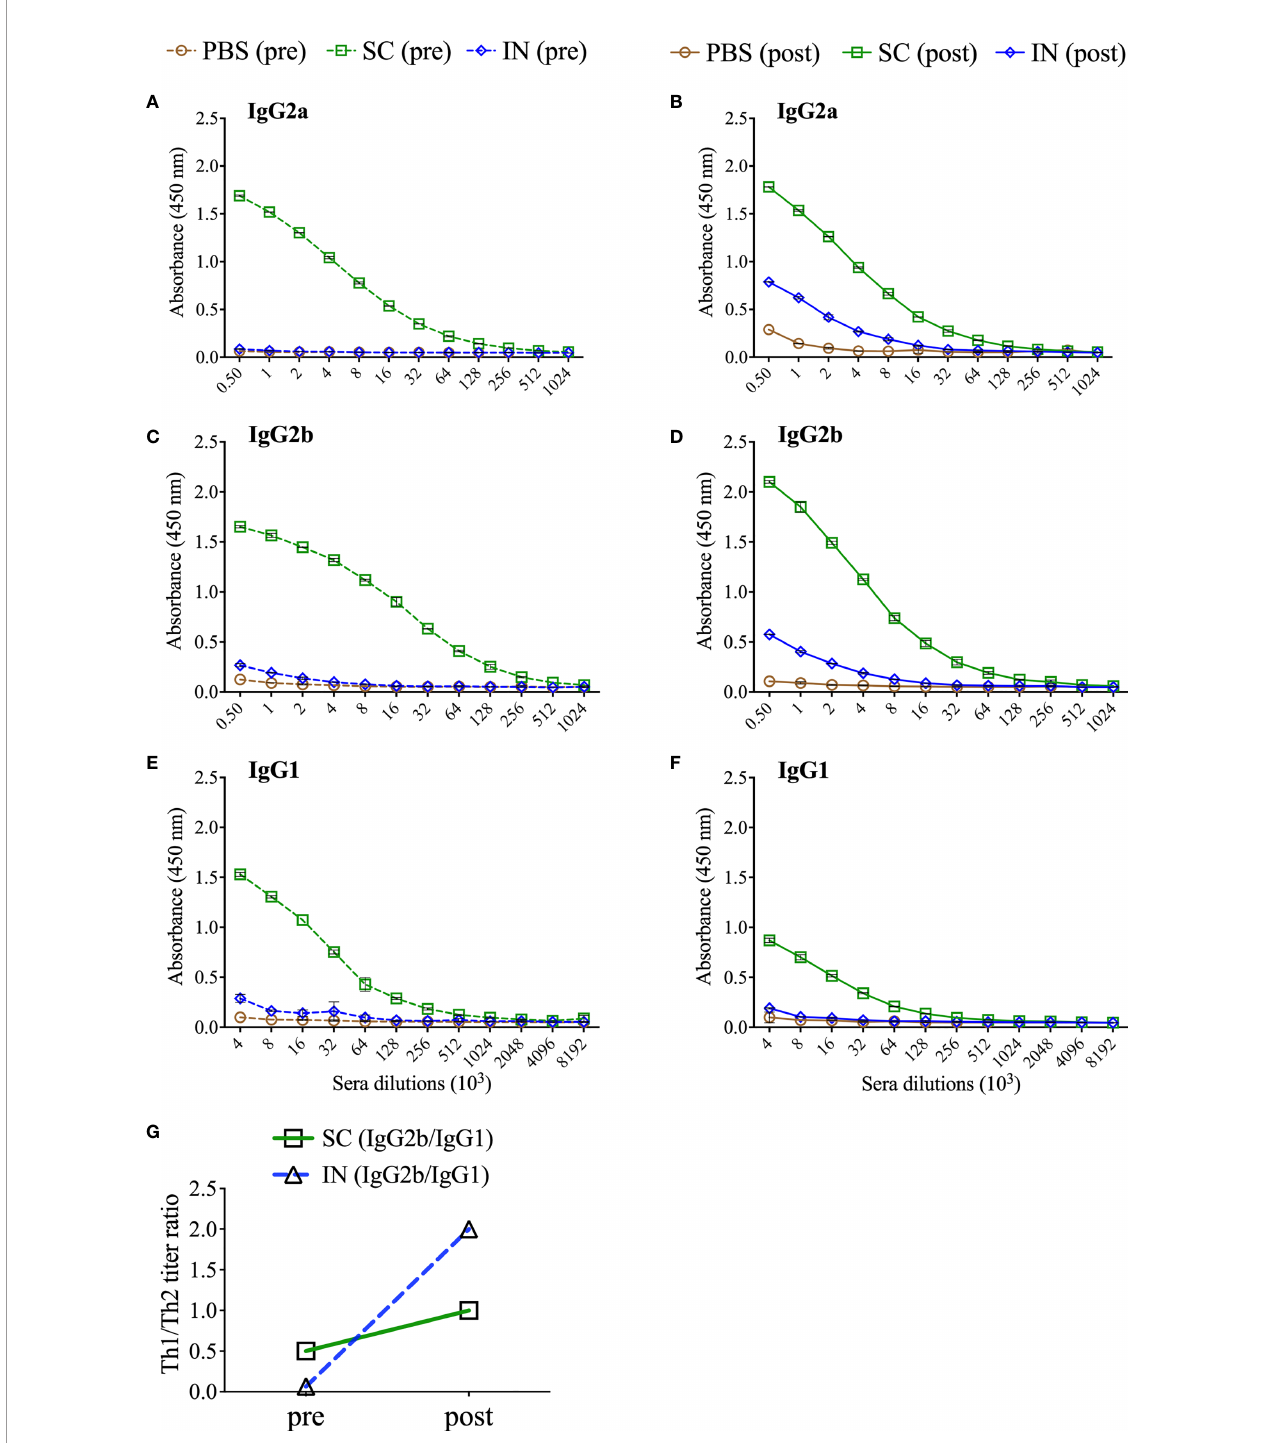
FIGURE 5 | PLGA-rMOMP immunization via the SC route induced enhanced antigen-speci fi c serum antibody isotypes. Groups of mice were immunized three-times at two-week intervals with either PBS or PLGA-rMOMP via the SC or IN routes. Each mouse was then challenged intravaginally with 1×10 5 IFU of C. muridarum , and pooled sera per group were used to quantify rMOMP-speci fi c antibody isotypes by ELISAs. Immunized mice (pre) sacri fi ced groups; IgG2a (A) , IgG2b (C) , IgG1 (E) , and immunized-challenge and re-challenge (post) groups; IgG2a (B) , IgG2b (D) , IgG1 (F) . Sera were diluted at a two-fold serial dilution to determine the endpoint antibody isotype titers. Pre and post Th1/Th2 ratio (G) for SC and IN groups. Each data point represents the mean ± SD of triplicates from each